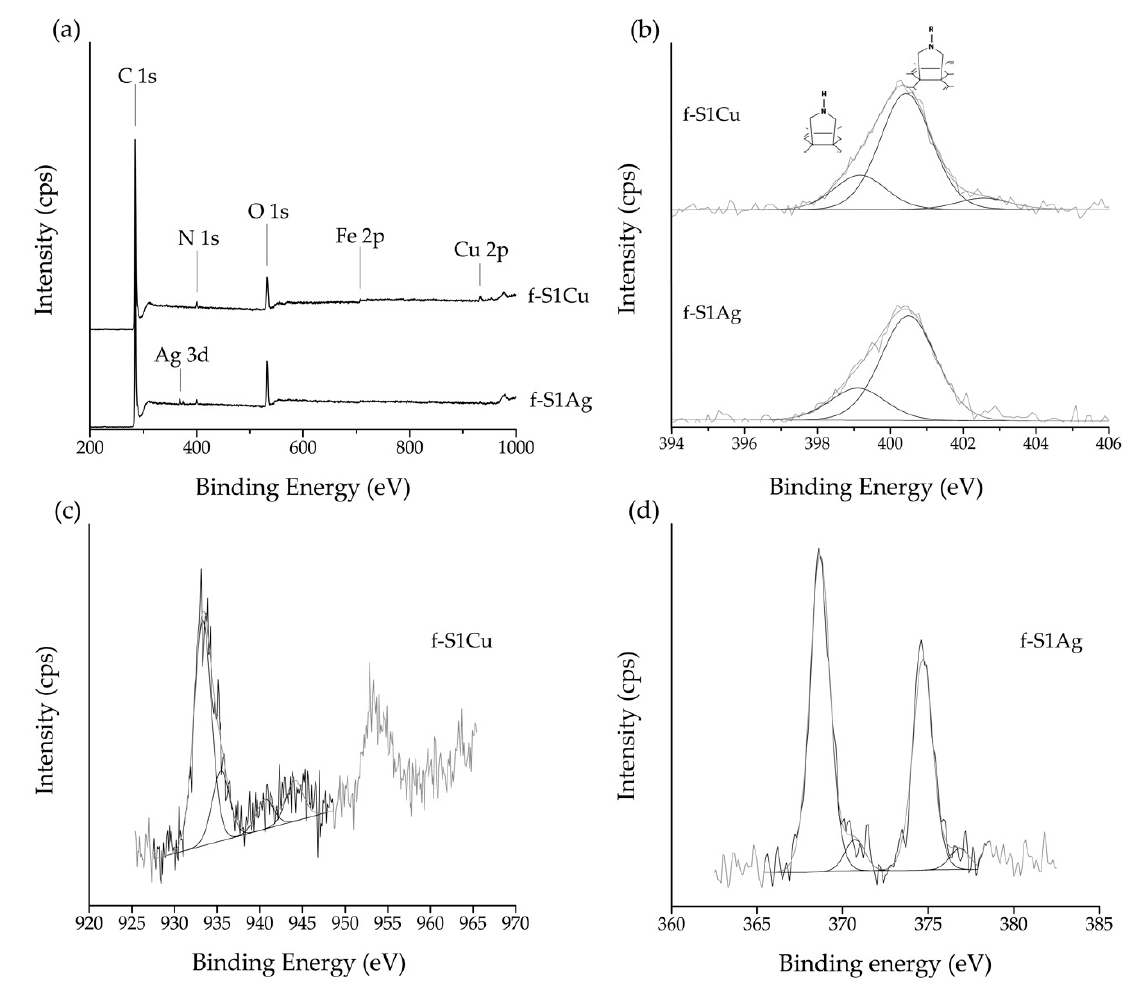
Figure 6. ( a ) Wide scan XPS spectra of h-SWCNT; deconvolution of high resolution XPS spectra of h-SWCNT ( b ) N 1s peak; ( c ) Cu 2p peak of f-S1Cu; and ( d ) Ag 3d peak of f-S1Ag. Table 4. Atomic percentages of the elements present in each sample, as obtained by